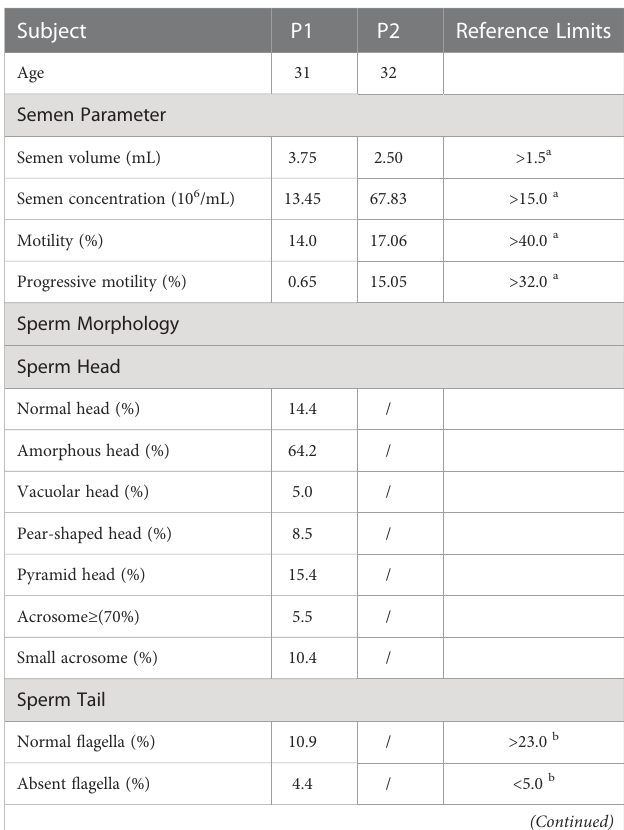
TABLE 2 Semen routine parameters and sperm morphology in men harboring homozygous HYDIN